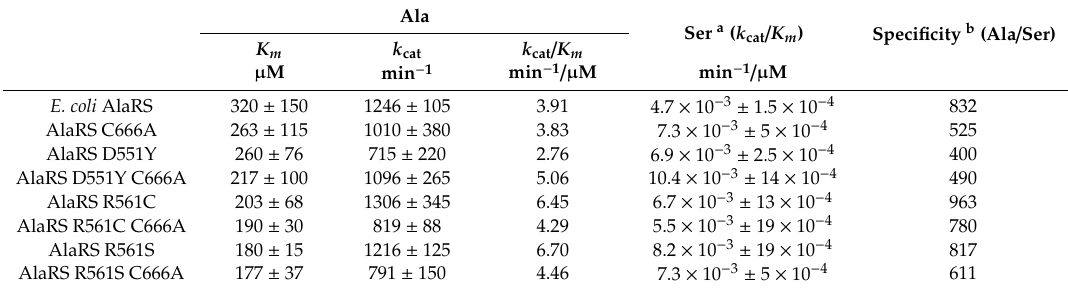
Table 1. Steady state activation kinetics of AlaRS C666A suppressors. Steady state kinetic parameters of the AlaRS C666A suppressors for the activation of alanine and serine were determined using pyrophosphate exchange. Ala Ser a ( k cat / K m ) Specificity b (Ala / Ser) K m k cat k cat / K m µ